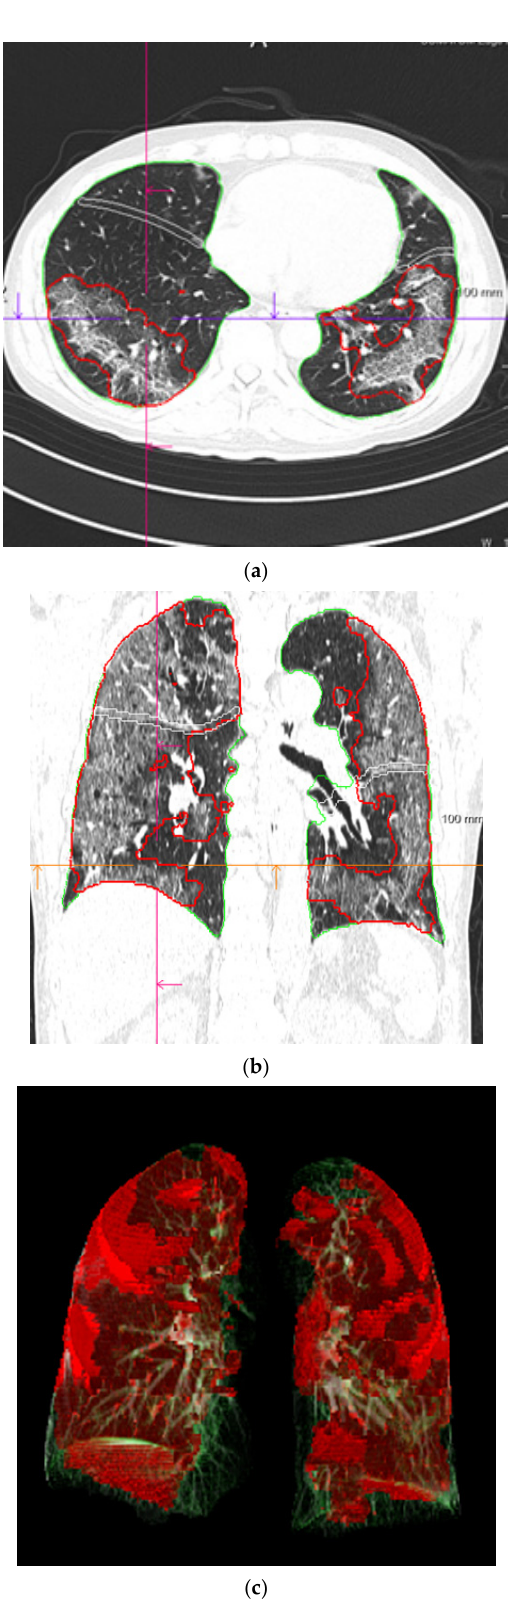
Figure 2. Lung and pneumonia area segmentation on CT images using deep learning-based analysis. Lung and pneumonia area on CT image segmented as three-dimensional data. A red border surrounds the pneumonia areas in the axial and coronal images ( a , b ). The pneumonia areas are visualized in a three-dimensional manner in red ( c ). CT: computed